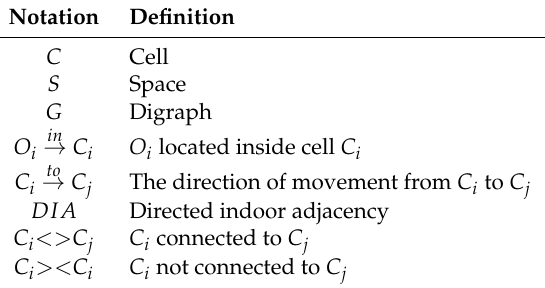
Table 1. Notations used throughout this